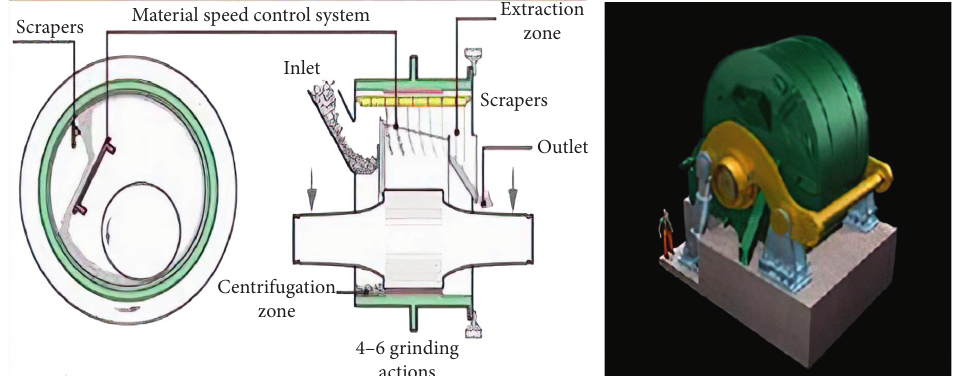
Figure 8: HOROMILL schematic